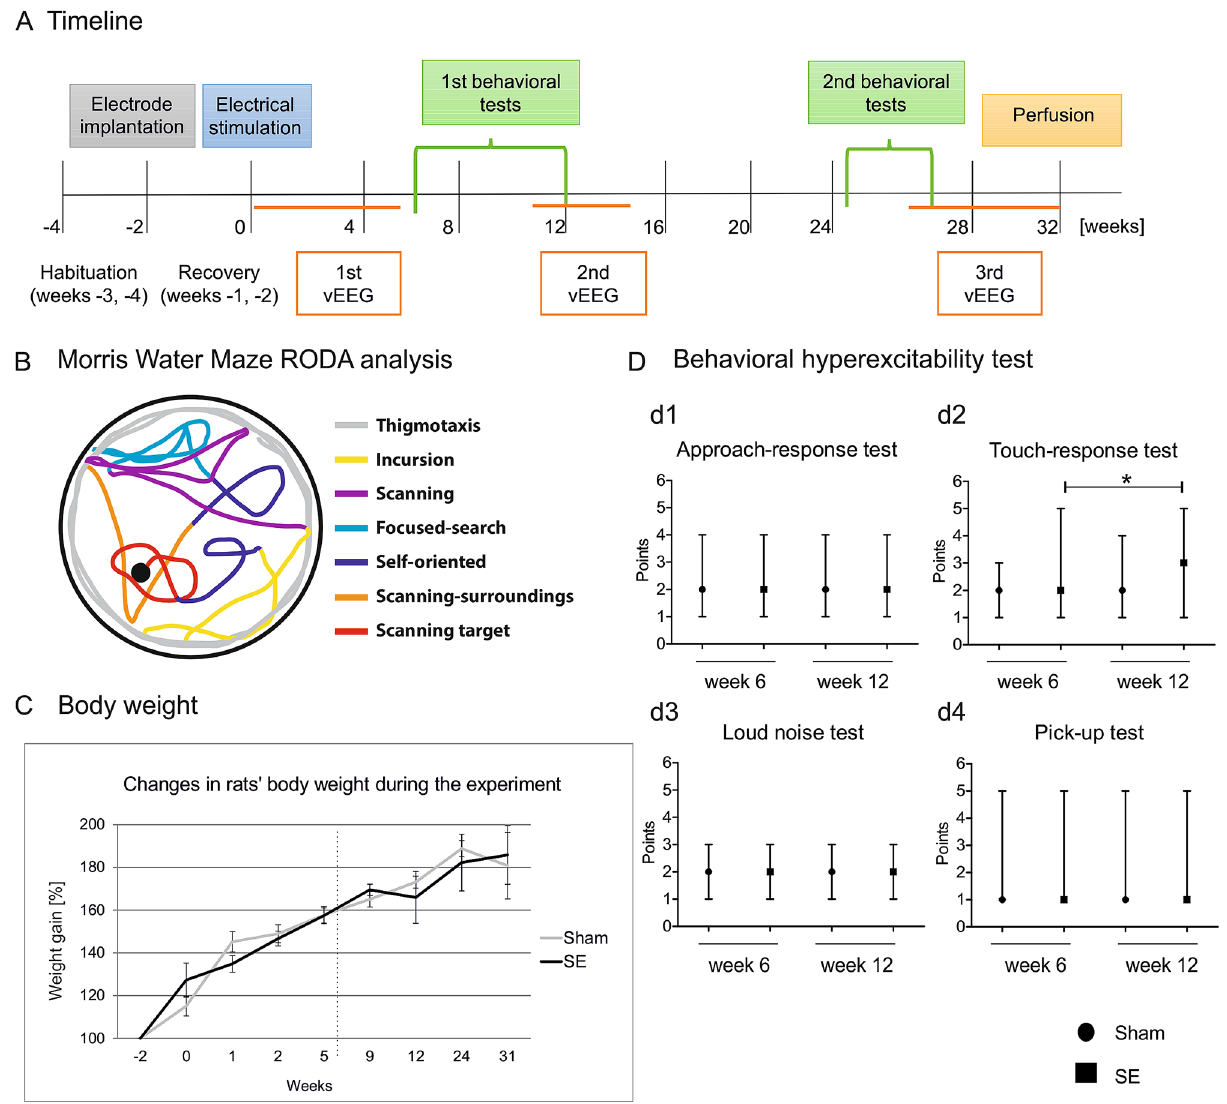
Figure 1. Experimental design, swimming strategies in the Morris water maze, and the animals’ wellbeing during the experiment between sham and stimulated rats. (A) Experimental design. Timeline of electrode implantation 2 weeks before electrical stimulation (0 week-start), video EEG (vEEG) monitoring, the battery of behavioral tests, and perfusion (32 week-end). (B) Schematic illustration of swimming strategies in the Morris water maze using Rodent Data Analysis (RODA) software. (C) Body weight in sham ( n = 12) and stimulated animals (SE, n = 15) during 31 weeks after electrical stimulation. No differences were observed between groups (mean ± SEM). (D) Behavioral hyperexcitability test. Notice a higher touch-response score in stimulated rats (SE, n = 15) at week 12 compared with week 6. * p < 0.05. The data are expressed as median and range (min,